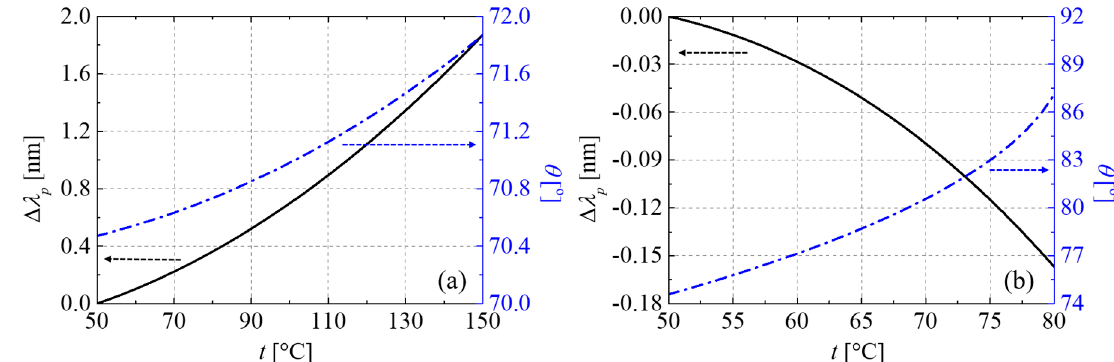
Figure 6. Temperature behaviors of the resonant λ p and the corresponding PM direction ( θ ) in two kinds of non-poled LNs: ( a ) LN and ( b ) 5 mol%-MgO:LN.